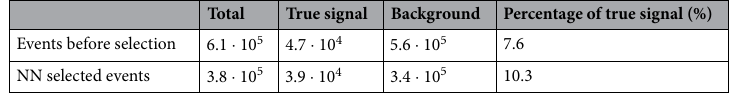
Table 1. Signal and background events in the validation set before and after NN